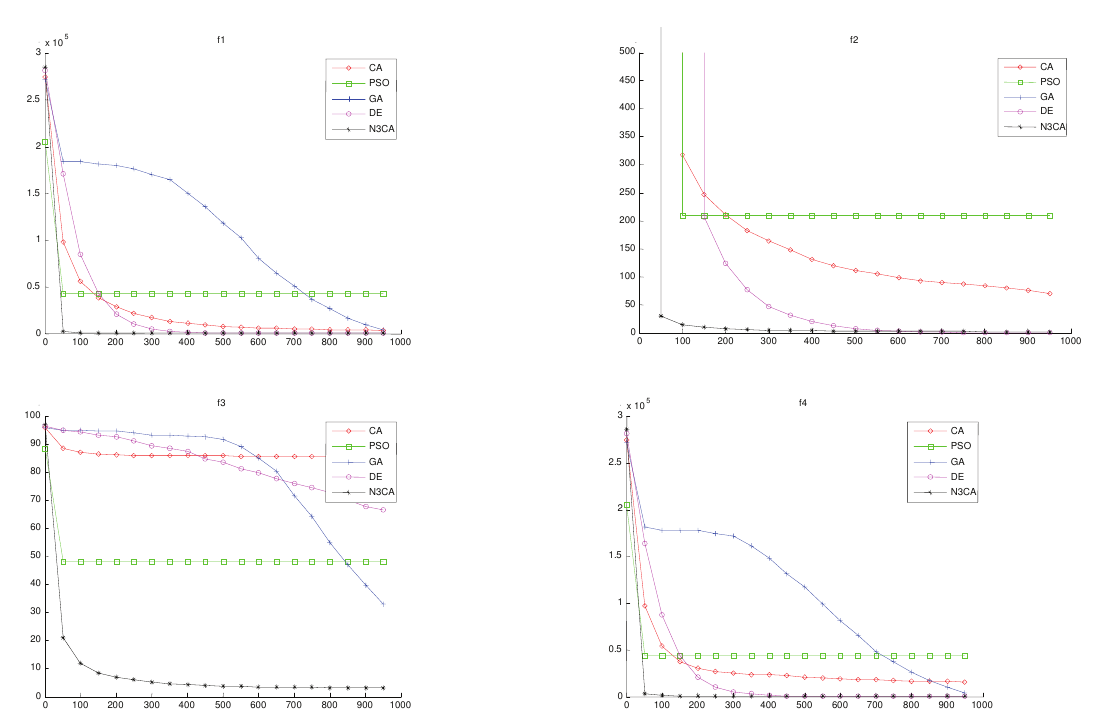
Fig. 3 . Convergence performance of the five algorithms on the 10 test functions. f 1, f 2, f 3 , f